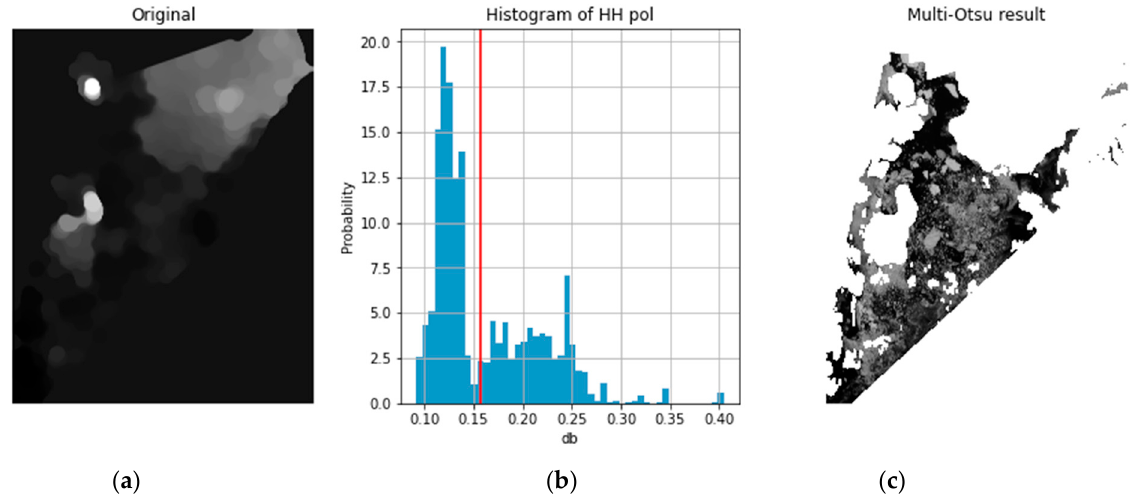
Figure 3. ( a ) Output of morphological closing ( A (cid:4593) ) of the S-1 images; ( b ) histogram of the S-1 backscatter of A (cid:4593) ; ( c ) segmentation result. Masked features are shown in white color.